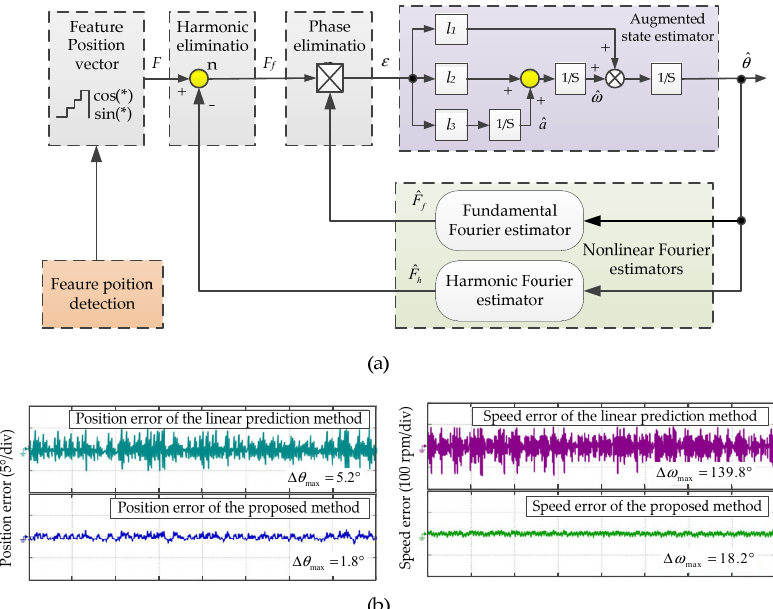
Figure 9. The principle block diagram of observer-based position sensorless control. ( a ) Observer ( b ) Contrast experiment [128].